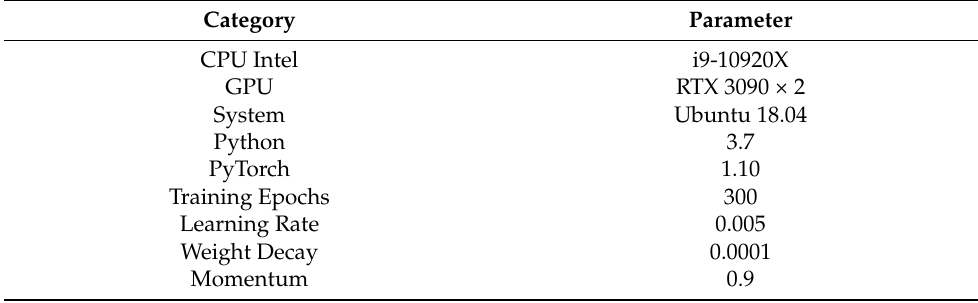
Table 2. Environment and parameter setting for the experiment setup.